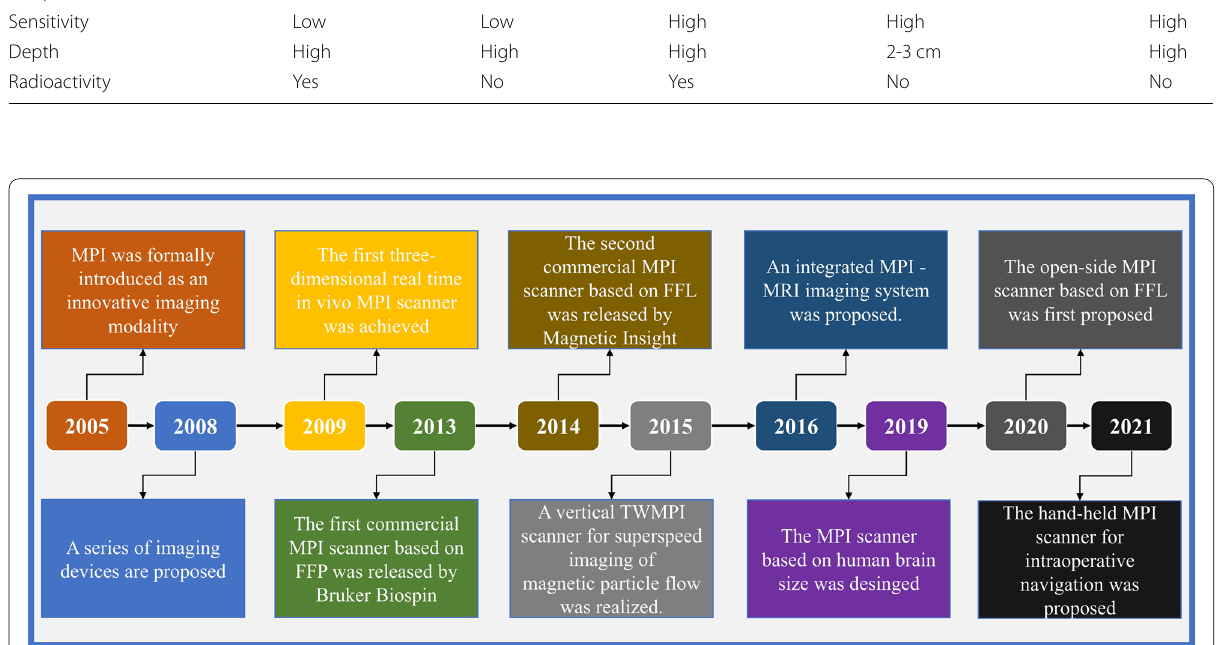
Table 1 Quantitative comparisons of different imaging modalities Property CT MRI PET/SPECT Optical imaging MPI Spatial resolution Temporal resolution 1 s Sensitivity Radioactivity Yes No Yes No